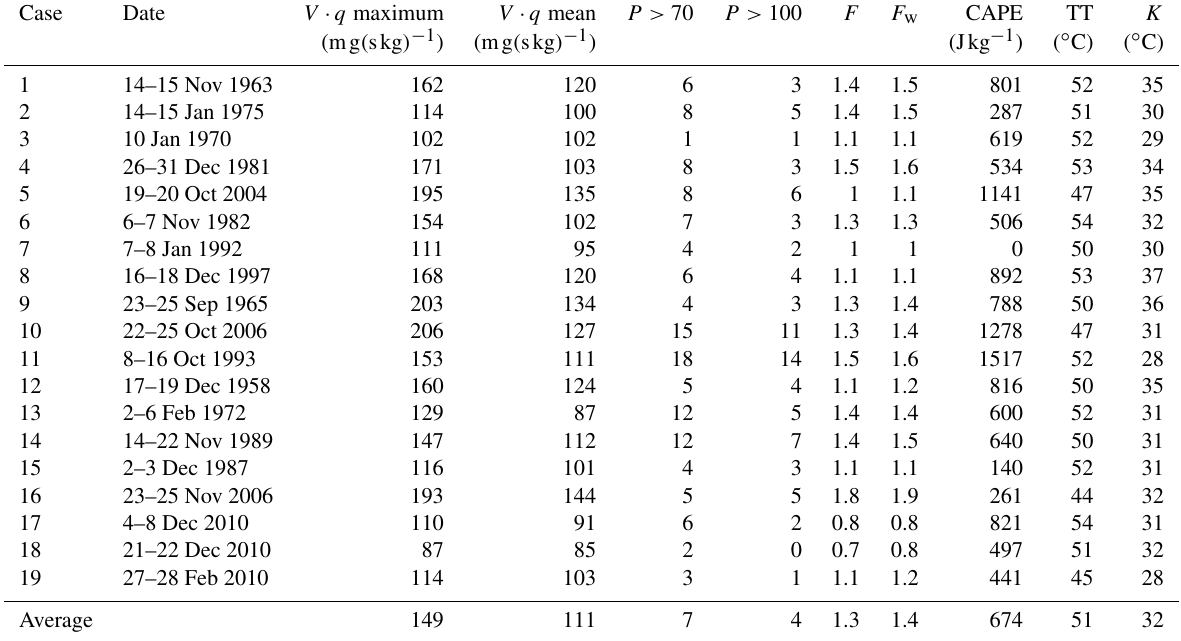
Table 1. Date and values of several meteorological indices for each case considered, at the point 40 ◦ 16 (cid:48) 31 (cid:48)(cid:48) N, 5 ◦ 09 (cid:48) 32 (cid:48)(cid:48) W. V · q is meridional moisture flux (mg ( skg ) − 1 ), P is number of 6h intervals with V · q higher than the indicated value (70 or 100), F is maximum dry Froude number, and F w is maximum moist Froude number at the 850hPa pressure level. The instability indices CAPE (Jkg − 1 ), TT (total totals), and K (maximum CAPE) are also shown. Case 19 is not taken into account to calculate the average since it was a singular case with little